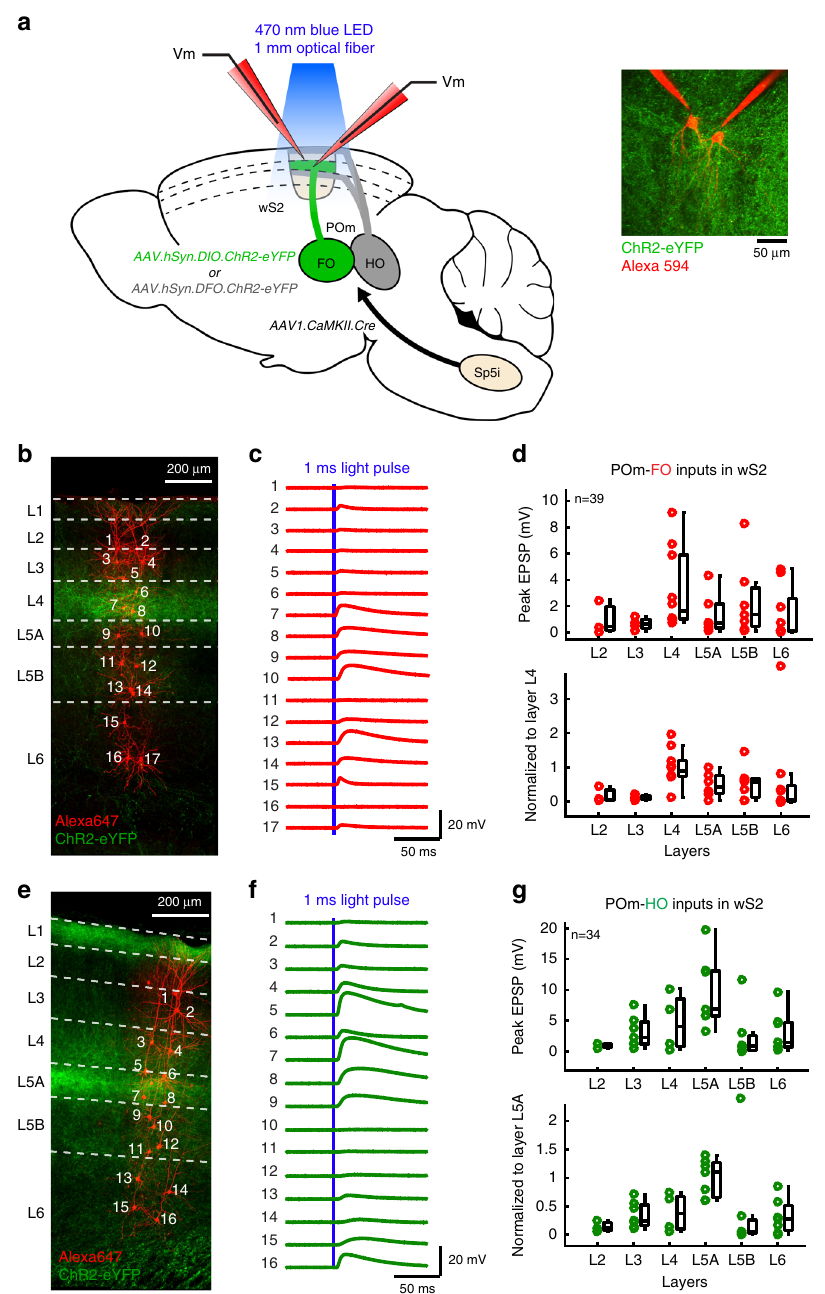
Fig. 2 Ex vivo whole-cell recordings in brain slices of POm-FO and POm-HO inputs to excitatory neurons across layers in wS2. a Schematic showing the strategy used to selectively express ChR2-eYFP in FO or HO subdivisions of POm. Method used to activate thalamocortical axons expressing channelrhodopsin-2 in order to evoke postsynaptic potentials in the somatosensory cortex is illustrated. A 470 nm wavelength light was delivered with a LED light source coupled with a 1 mm optic fi ber onto wS2. Inset: Two-photon microscopy image of an in vitro whole-cell patch – clamp recording of two neurons fi lled with Alexa 594. b Confocal z-projection of wS2 in a parasagittal slice after fi xation. ChR2-eYFP was expressed in POm-FO axons, and recorded neurons were fi lled with biocytin followed by staining with streptavidin conjugated to Alexa 647. This experiment was repeated in three mice with similar results. c Light-evoked excitatory postsynaptic potentials (EPSPs) from recorded neurons labeled in b following 1 ms light pulses. d Top: Peak amplitude of EPSPs evoked by optogenetic stimulation of POm-FO axons recorded in cortical excitatory neurons ( N = 3 mice, n = 39 neurons) across different layers in wS2. On each box, central mark indicates the median and edges indicate 25th and 75th percentiles. The whiskers extend from the minimum data point comprised within 1.5× of the interquartile range to the 25th percentile and from the maximum data point comprised within 1.5× of the interquartile range to the 75th percentile. Bottom: same responses normalized to the average peak EPSP recorded in the main input layer (L4) for each experiment. e – g Same as b – d but for POm-HO axon stimulation during whole-cell recording of neurons in wS2 ( N = 3 mice with similar results, n = 34 neurons). Here, EPSPs were normalized to the average peak EPSPs from L5A neurons for each